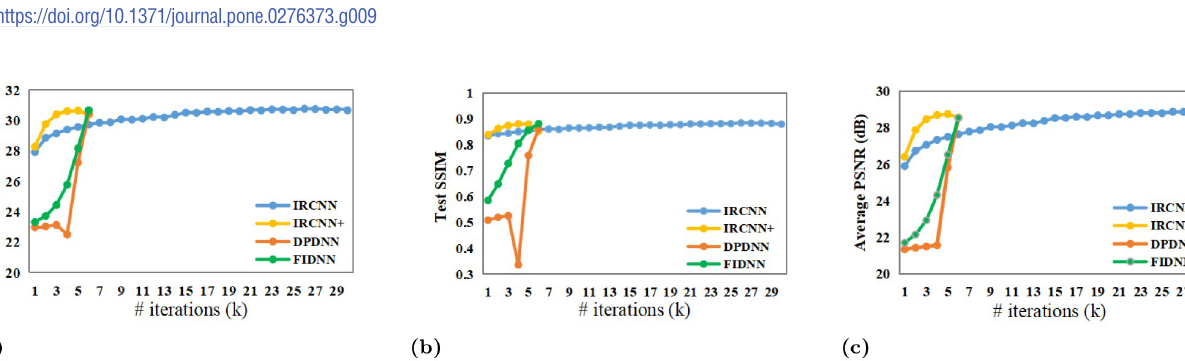
Fig 10. Comparison of PSNR and SSIM results for motion blur kernel size 17 and noise level 7.65. (a): PSNR results on ‘Parrrot’ image; (b): SSIM results on ‘Parrrot’ image; (c): Average PSNR results on Set10 dataset.